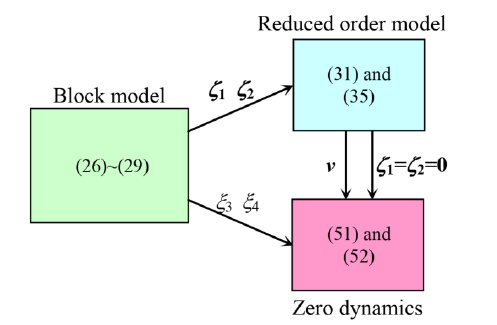
Figure 2. The decomposition of the block